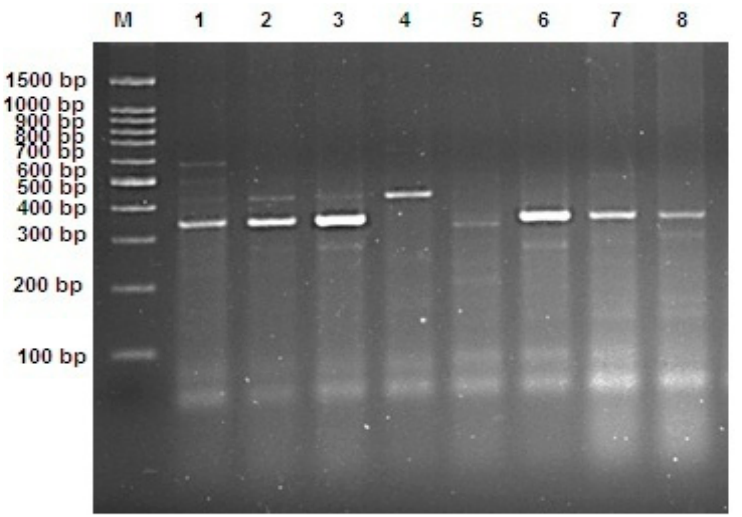
Figure 4. Ethidium bromide-stained 1.5% agarose gel with multiplex PCR products showed C. botulinum neurotoxin genes from eight bacterial samples isolated from the Beheira governorate (lanes 1–8), where M represents a 1500 bp DNA ladder.